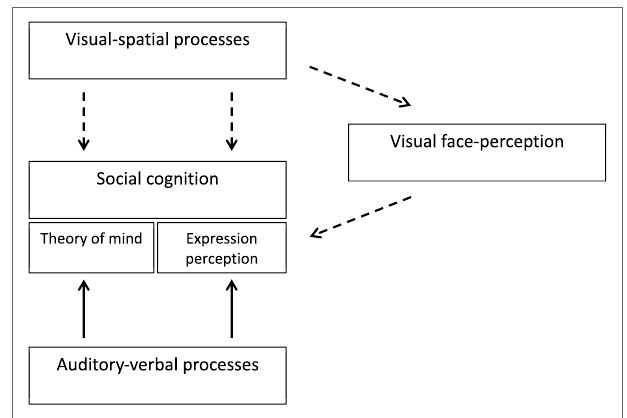
FigUre 5 | A theoretical model of social cognition in Turner syndrome (TS) and its relationship to other perceptual and cognitive capacities. The broken lines represent TS impairments while the full lines represent intact